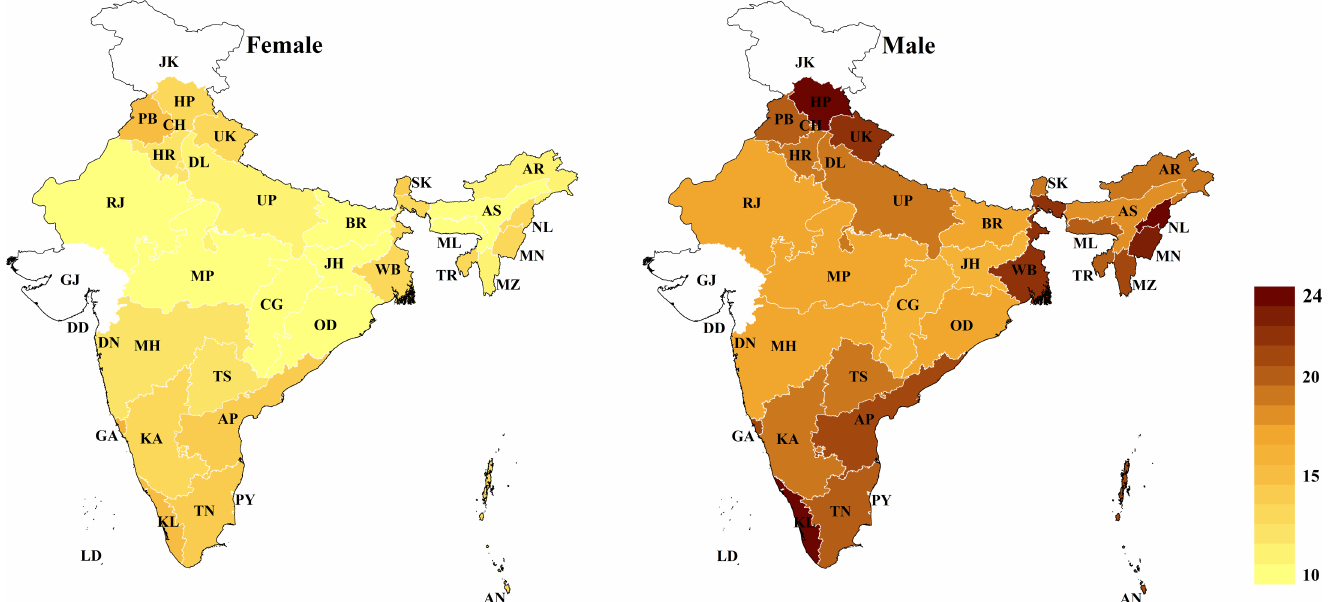
Fig 1. Age-standardized state-level mean 10-year risk of a cardiovascular disease event (percent as calculated by the Framingham risk score), by sex. The Global Burden of Disease project’s 2013 population for India was used for age standardization [36]. No data were available for Gujarat and Jammu and Kashmir. AN, Andaman and Nicobar Islands; AP, Andhra Pradesh; AR, Arunachal Pradesh; AS, Assam; BR, Bihar; CG, Chhattisgarh; CH, Chandigarh; DD, Daman and Diu; DL, Delhi; DN, Dadra and Nagar Haveli; GA, Goa; GJ, Gujarat; HR, Haryana; HP, Himachal Pradesh; JH, Jharkhand; JK, Jammu and Kashmir; KA, Karnataka; KL, Kerala; LD, Lakshadweep; MP, Madhya Pradesh; MH, Maharashtra; MN, Manipur; ML, Meghalaya; MZ, Mizoram; NL, Nagaland; OD, Odisha (Orissa); PB, Punjab; PY, Puducherry; RJ, Rajasthan; SK, Sikkim; TN, Tamil Nadu; TS, Telangana State; TR, Tripura; UP, Uttar Pradesh; UK, Uttarakhand (Uttaranchal); WB, West